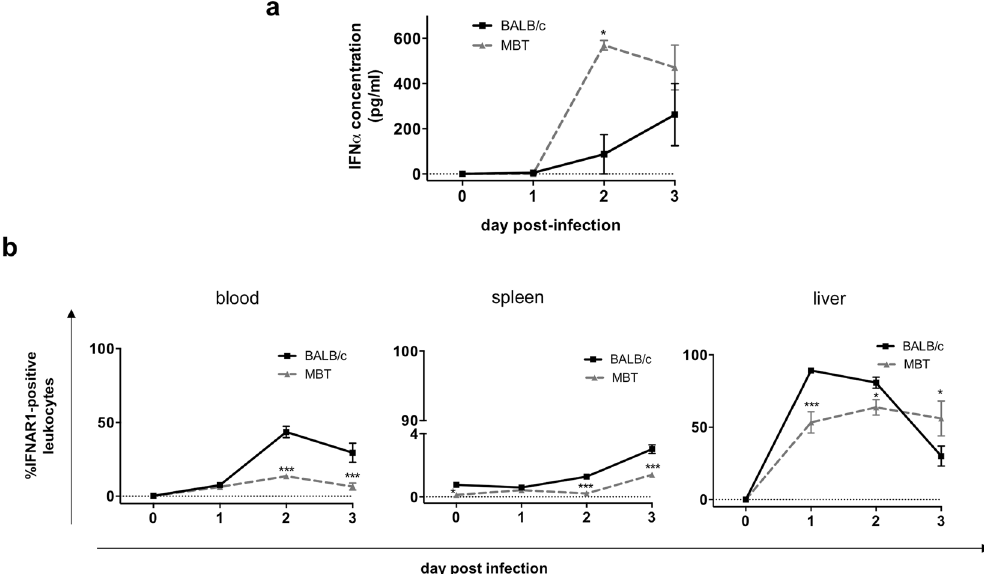
Figure 6. Greater IFN- α expression, but weaker IFNAR1 expression in MBT mice. (a) Serum IFN- α concentrations in BALB/c and MBT mice on days 0–3 post infection (n = 8 per strain, infected, n = 3 per strain, sham-infected). (b) Percentages of total IFNAR1-positive leukocytes in the blood, spleen, and liver of BALB/c and MBT mice as measured by flow cytometry. Cytometry experiments were performed twice (n = 5 mice/ strain/timepoint). Representative experiments are displayed. Data are represented as mean ± SEM. Two-way ANOVA was used to test differences between means. * P values < 0.05, ** P < 0.01, and *** P <